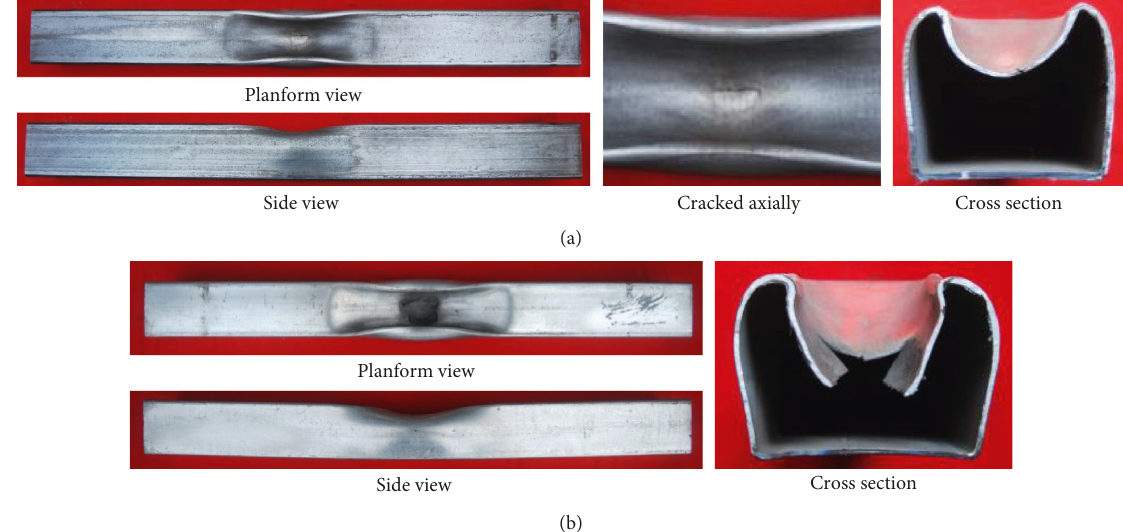
Figure 6: Typical failure modes of square tube in Mode II. (a) The square tube is just cracking ( a � 4.0mm, R � 13cm, m � 100g + 160g, TZ33). (b) The crack presents a radial H-type crack ( a � 3.0mm, R � 18cm, m � 100g + 160g,